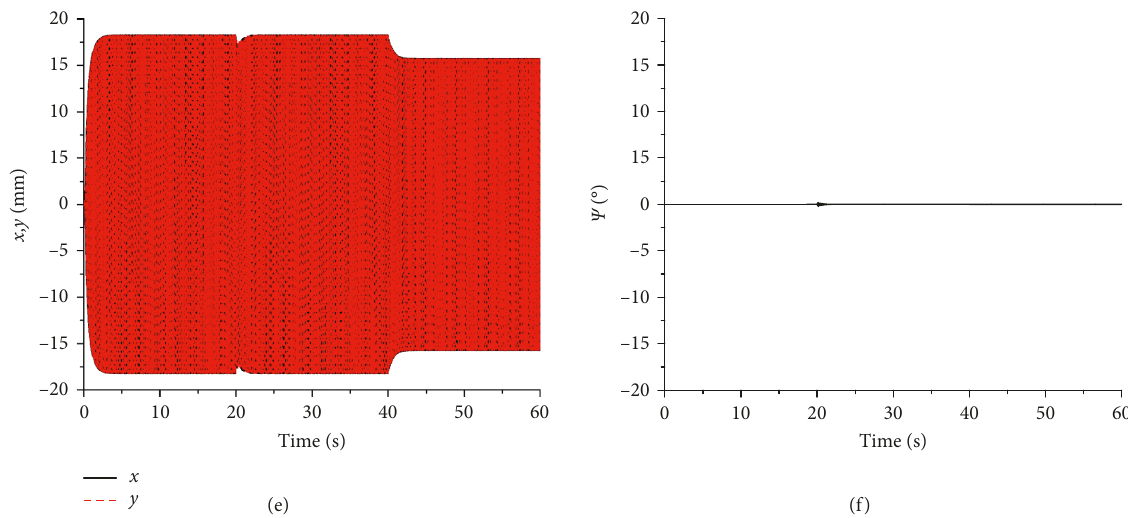
Figure 8: Results of computer simulations for η 1 (cid:31) η 2 (cid:31) η 3 (cid:31) η 4 (cid:31) 1. (a) Rotational velocities of the four motors; (b) phase difference between vibrator 1 and 2; (c) phase difference between vibrator 2 and 3; (d) phase difference between vibrator 3 and 4; (e) displacements in x and y directions; (f) displacement in ψ direction.